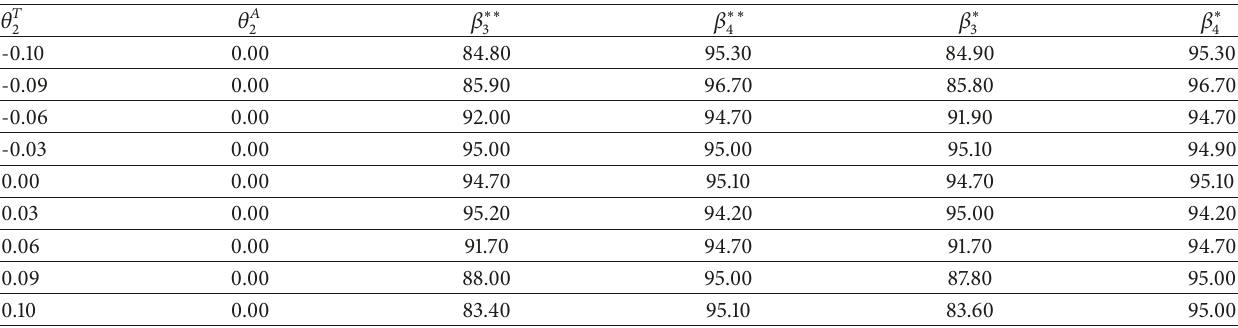
Table 1: CI coverage in percent for the estimated 𝛽 3 and 𝛽 4 at assumed 𝜃 2 =0. We use 𝜃 𝑇 2 for the true 𝜃 2 , 𝜃 𝐴 2 for the assumed value in adjusting the estimates, ( 𝛽 ∗∗ 3 , 𝛽 ∗∗ 4 ) for the Copas and Eguchi adjustment method, and ( 𝛽 ∗ 3 , 𝛽 ∗ 4 ) for the least false adjustment method. Results based on 1000 samples of size 1000.